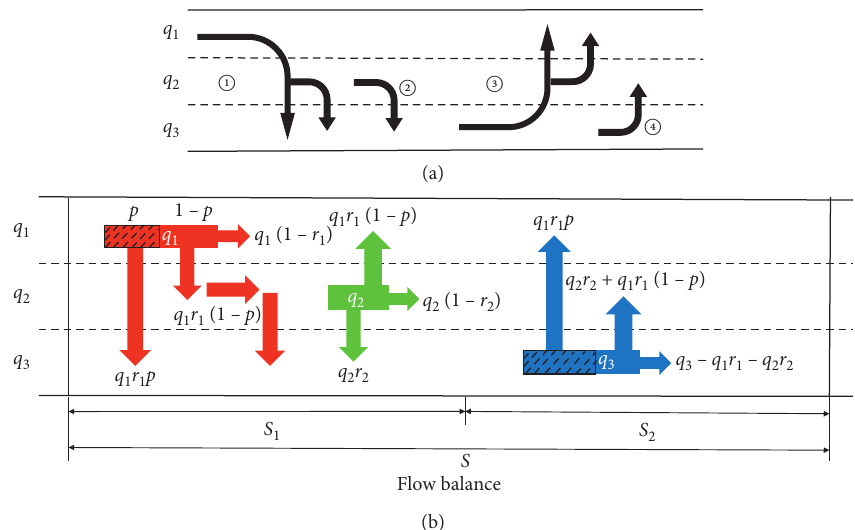
Figure 2: Lane-changing behaviors in three lanes: (a) path selections in lane-changing behaviors in the space of lane-changing and (b) schematic diagram of lane-changing behaviors in three lanes.